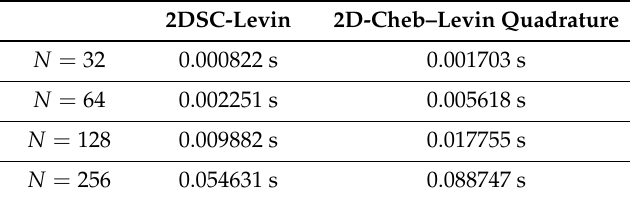
Table 5. Comparison of CPU time for 2DSC-Levin and 2D-Cheb–Levin quadrature for fixed ω = 1000.